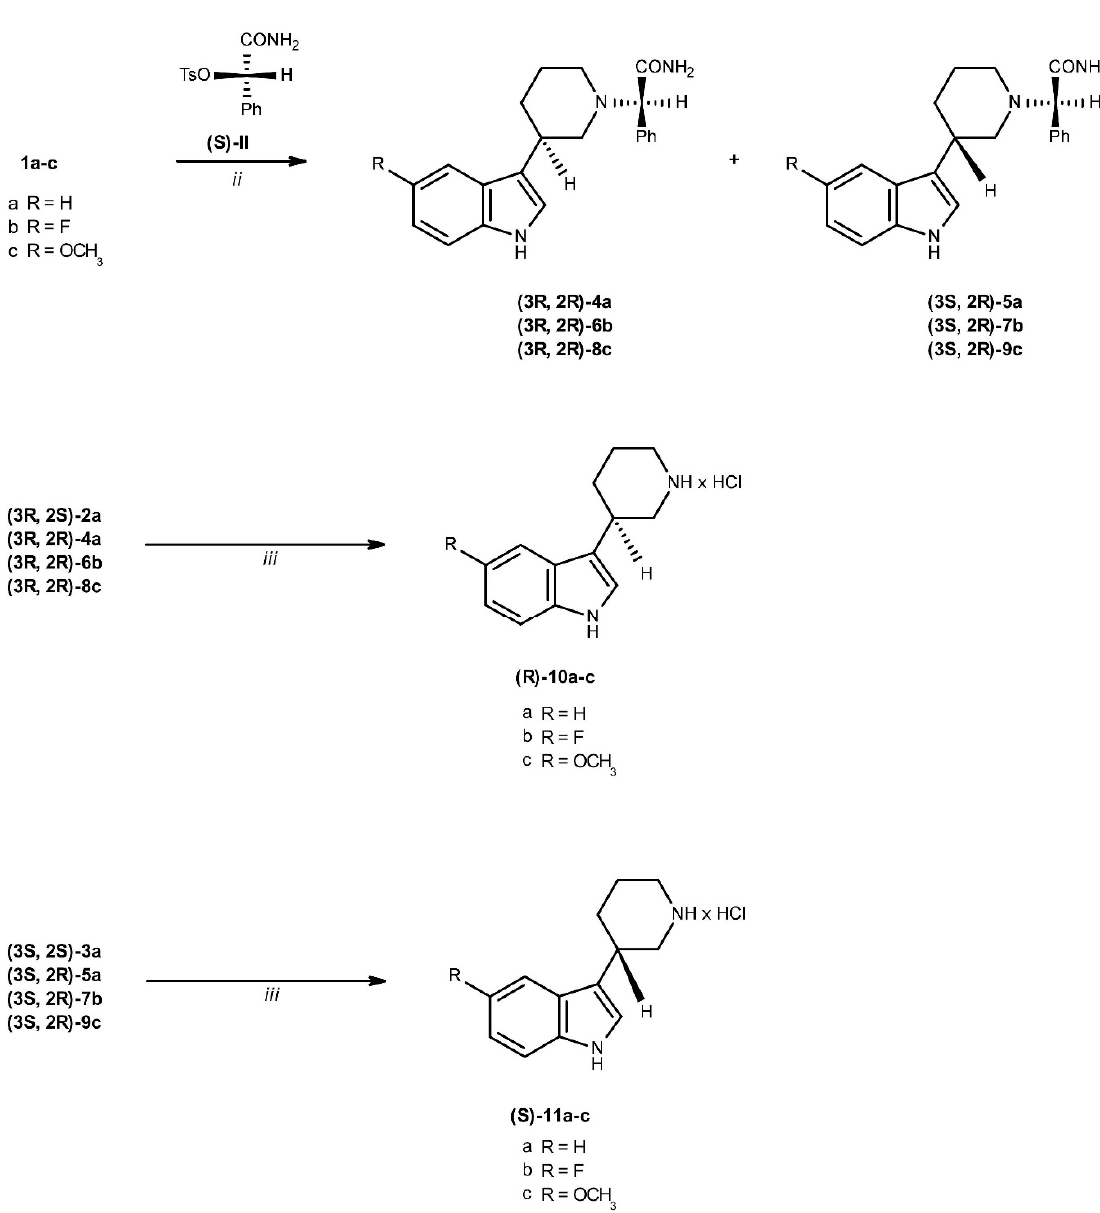
Scheme 2. Reagents and conditions: ( ii ) K 2 CO 3 , CH 3 CN, 45 ◦ C; ( iii ) H 2 , Pd/C 10%, MeOH, r.t. 5